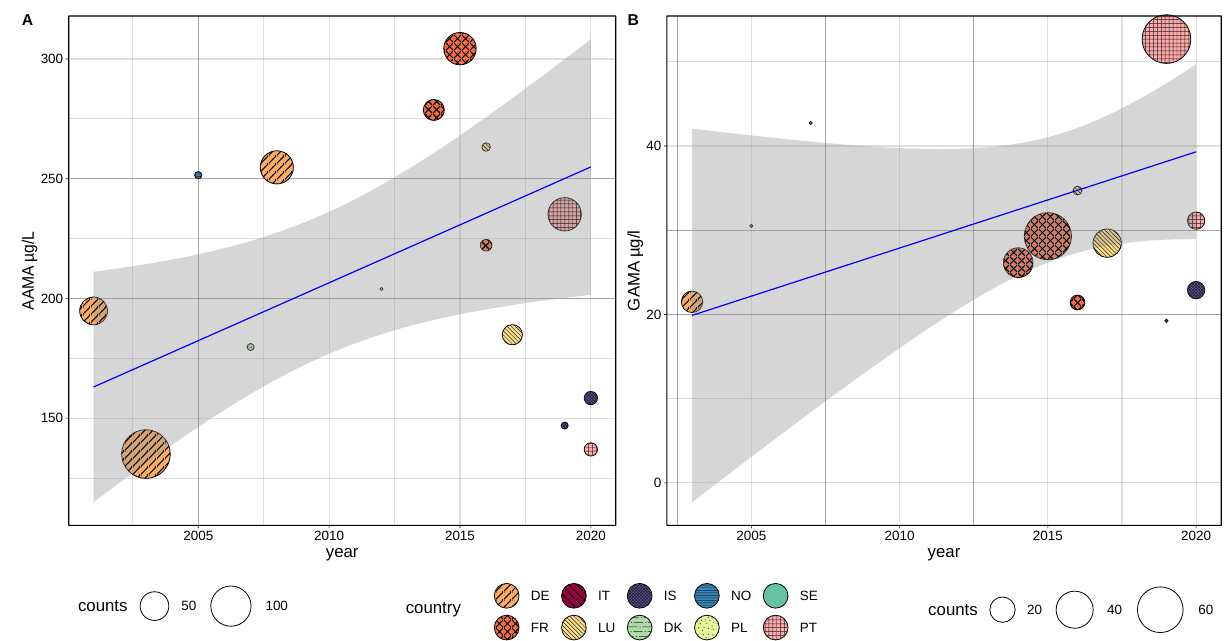
Figure 6. Linear model (regression) of harmonized means of acrylamide biomarkers AAMA and GAMA in smokers as reported by European published papers and HBM4EU Aligned Studies. Study means represented by country based color-coded dots with size dependent on the corresponding sample number. Population size is represented by the size of the circles indicating single